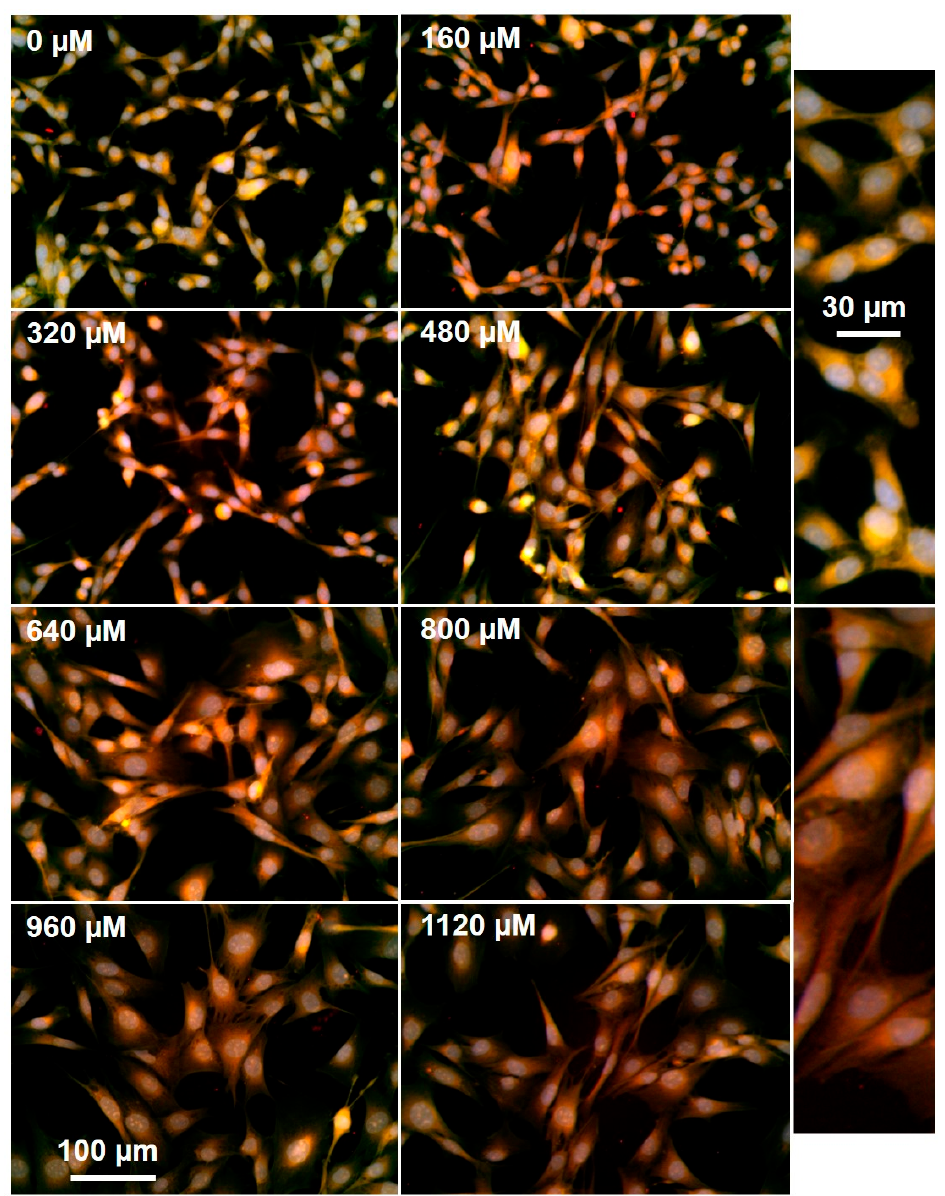
Figure 5. GBM157 cells with increasing (0–1120 µM) concentrations of TMZ, with active MGMT measured using 100 µM O 6 PGG/Azido-PEG-FITC (Green) and Mitosox